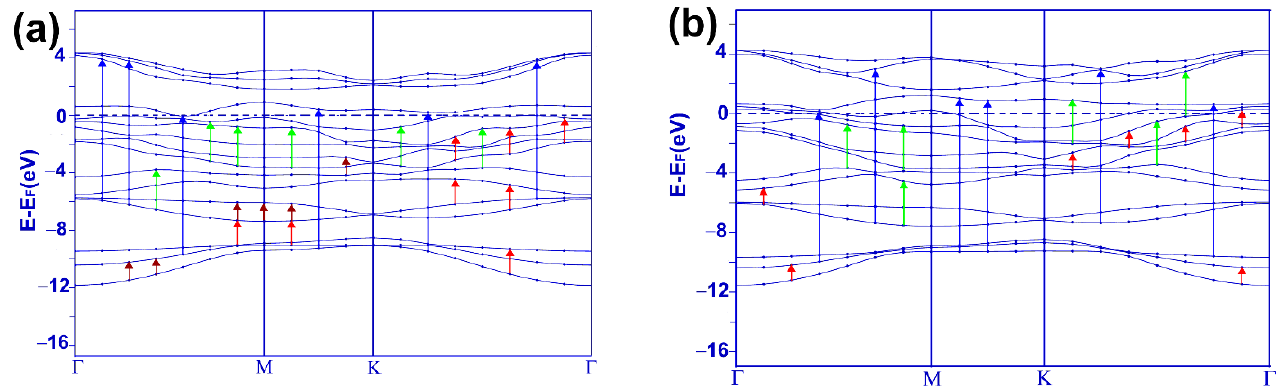
Figure 5. Energy band structures for the systems MoP 2 -CO ( a ) and NbP 2 -CO ( b ). The dashed horizontal line at zero indicates the Fermi energy . The arrows indicate some possible transitions during absorption to explain the maxima in the absorption spectra. Thus, the dark red arrows demonstrate the first peak’s presence in the infrared absorption of the combined system MoP 2 -CO. The red arrows in ( a,b ) show some possible transitions for the most prominent peaks in the infrared. In this way, the green and blue arrows indicate some possible shifts to explain the presence of the main peaks in the visible and ultraviolet ranges, respectively.